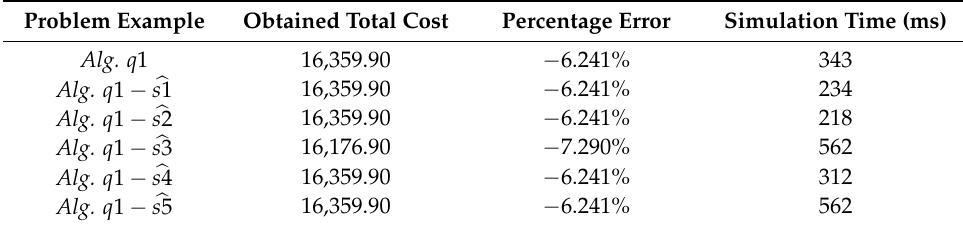
Table 7. Obtained results for regular network GR-3 (Suboptimal cost